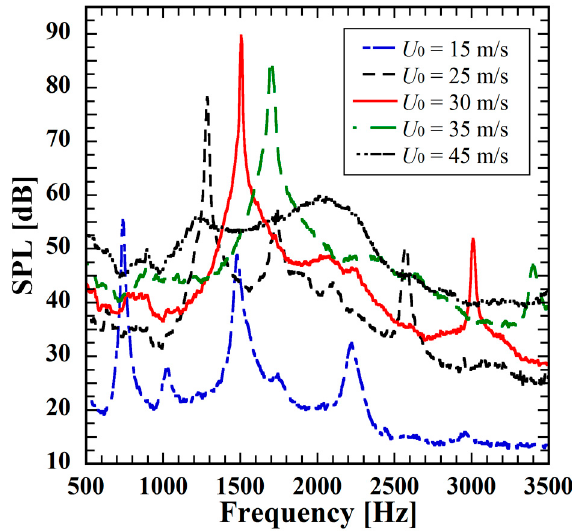
Figure 4. Measured sound-pressure spectra without control at U 0 = 15, 25, 30, 35, 45 m/s. SPL is the sound-pressure level in decibels